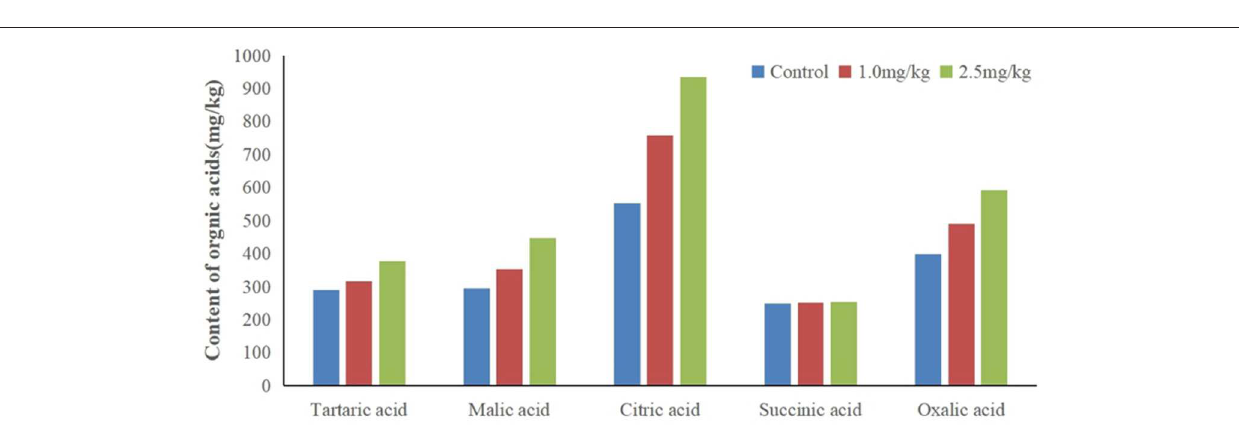
FIGURE 5 | Contents of different organic acids in root exudates of snapdragons under cadmium